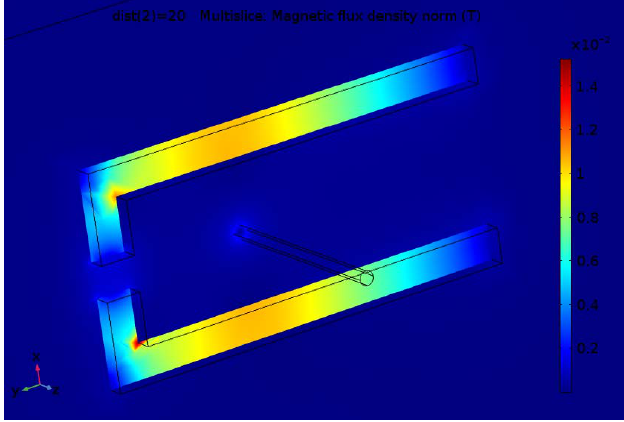
Figure 3. Flux density distribution for the construction with one air gap.